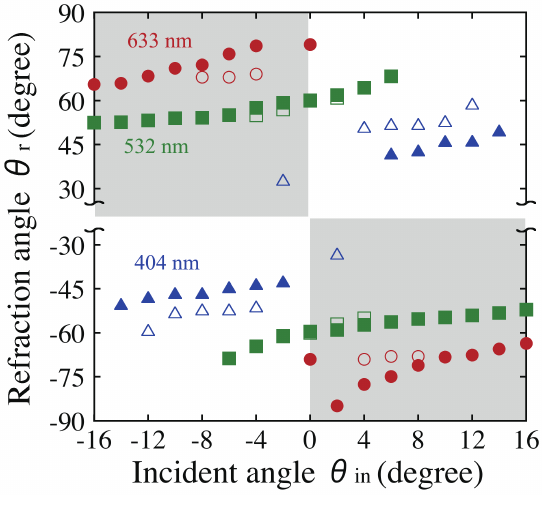
Figure 13. Refraction angles as a function of incident angle at different wavelengths and at s polarization. Measured and calculated data points are denoted by ( N , (cid:4) , • ) and ( △ , (cid:3) , ◦ ) at (404 nm, 532 nm, 633 nm), respectively. The white and gray regions denote positive and negative refraction,